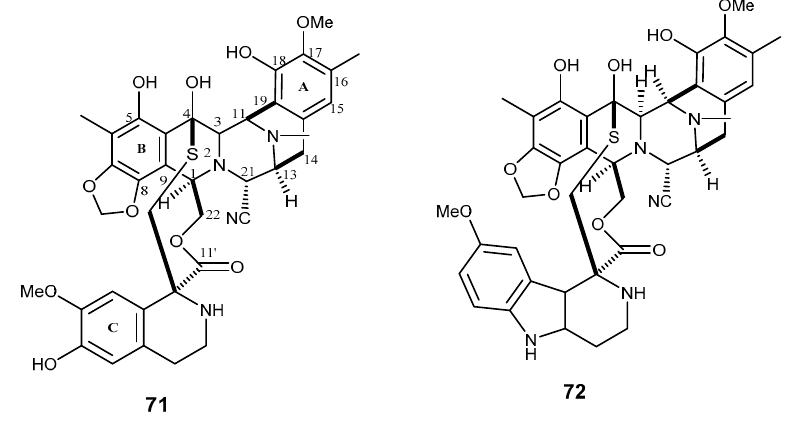
Figure 13. Structures of trabectedin ( 71 ) and lurbinectedin ( 72 ).